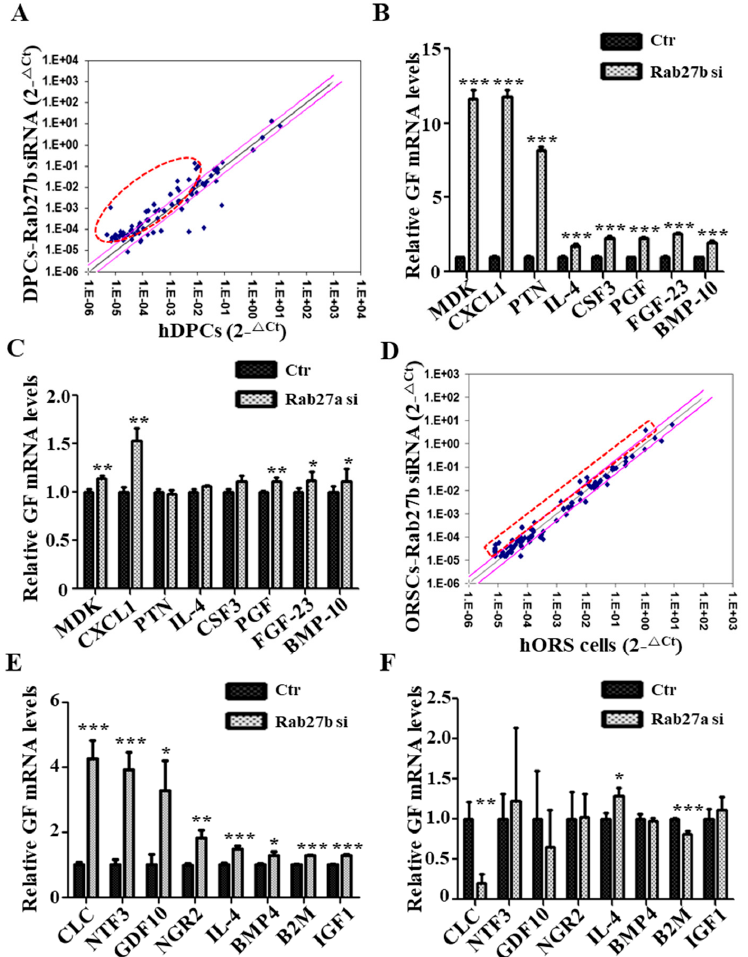
Figure 5. Rab27b inhibition increased expression of various growth factors. ( A ) Scatterplot of qPCR analysis of control and Rab27b siRNA-treated-hDPCs sample. ( B ) Inhibition of Rab27b promoted large production of multiple growth factors, approximately 2- to 12-fold in hDPCs. ( C ) However, Rab27a inhibition had a minor e ff ect on the increase or decrease in expression of these growth factors except CXCL1 in hDPCs. ( D ) Scatterplot of qPCR array analysis of control and Rab27b siRNA-treated-hORS cells. ( E ) Inhibition of Rab27b promoted the production of multiple growth factors, approximately 1.2- to 4-fold in hORS cells. ( F ) On the other hand, Rab27a inhibition had little e ff ect on the production of most growth factors, except for Charcot-Leyden crystal protein ( CLC ) and β -2-microglobulin ( B2M ). GF; growth factor, si; siRNA. * p < 0.05, ** p < 0.01, *** p < 0.001 using Student’s t test. Three independent experiments were conducted for all data points. All error bars indicate